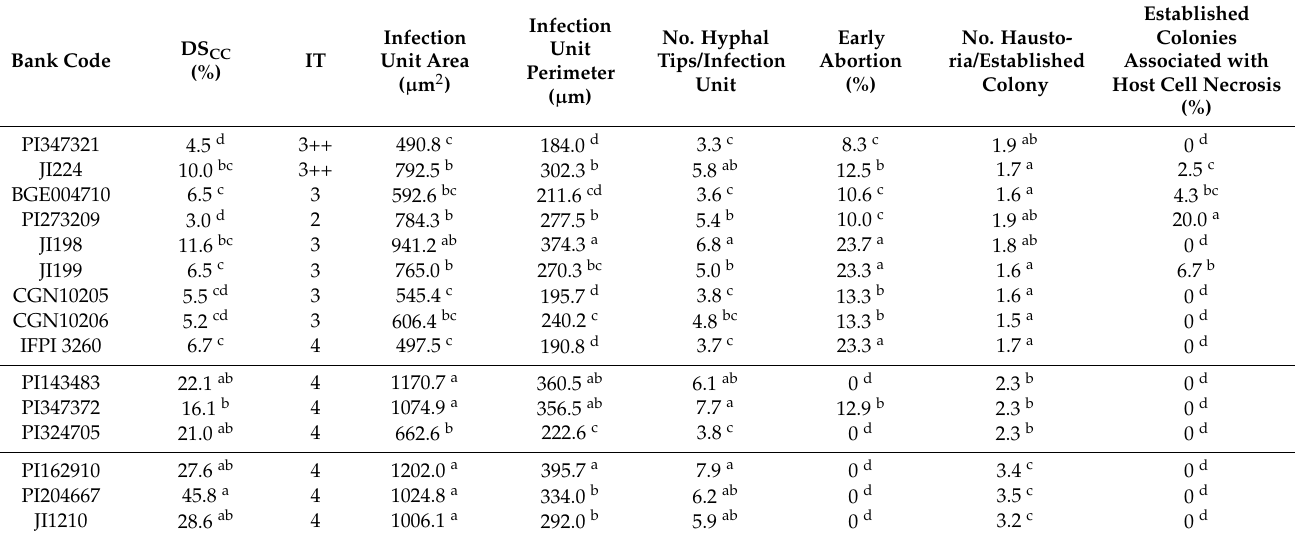
Table 5. Microscopic evaluation of U. pisi colonies 48 h post-inoculation in the selected genotypes. Values, per column, followed by different letters differ significantly at p <